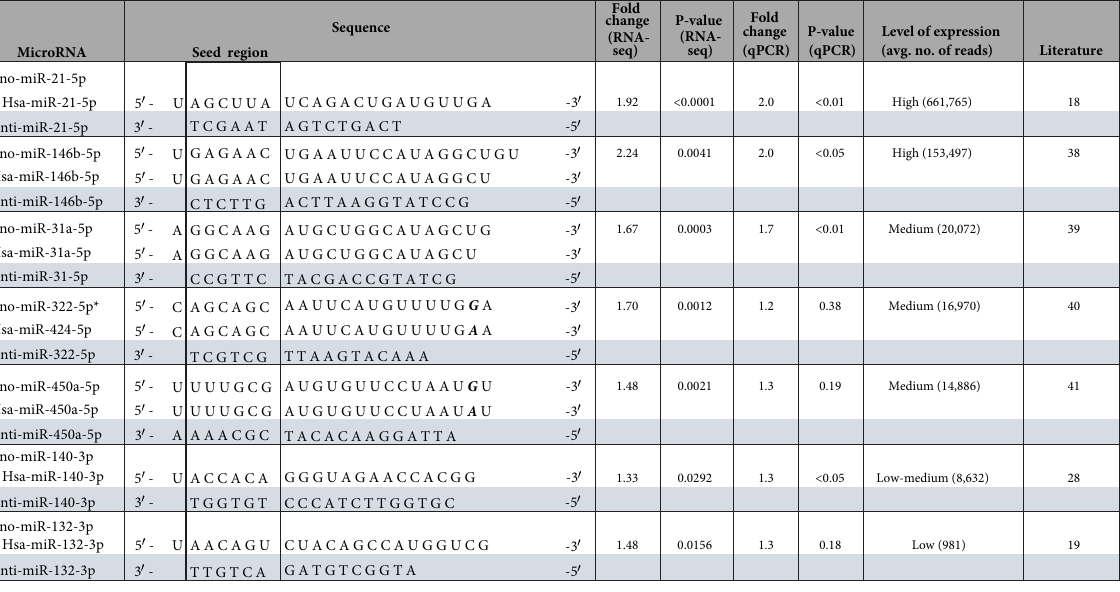
Table 1. Overview of microRNA sequences and differential expression analysis in AE-EHTS compared to control EHTs. * previously